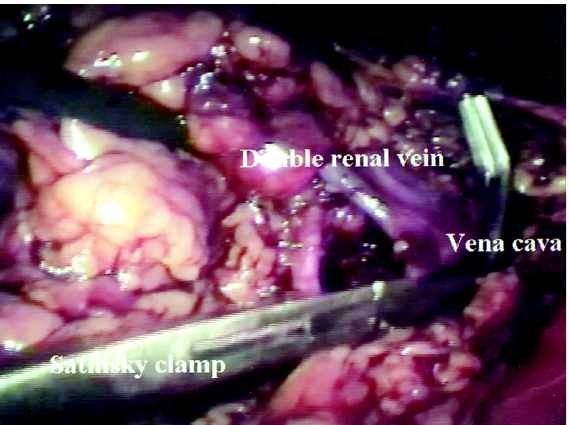
Figure 4 – Final aspect of the inferior vena